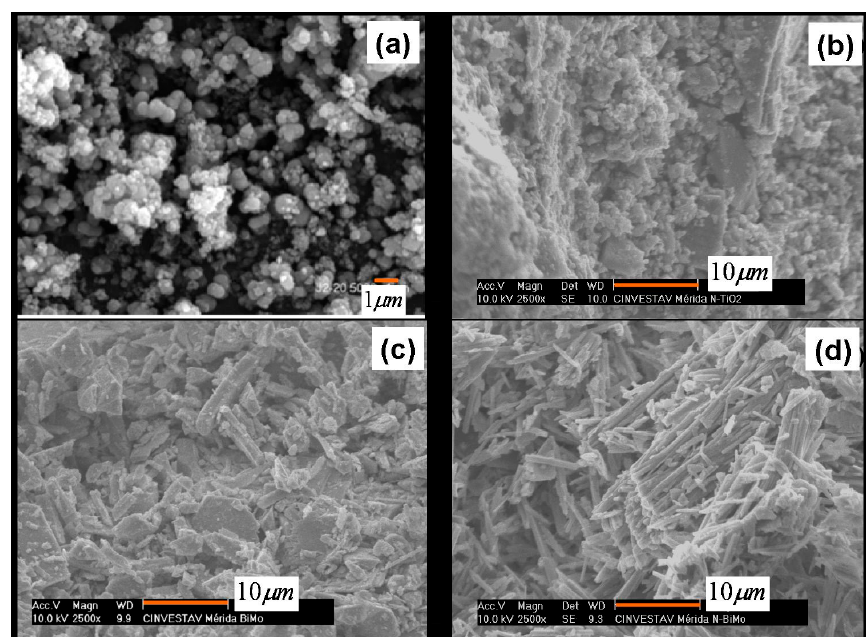
Figure 1. Scanning Electron Microscopy (SEM) photo-micrograph obtained at 5000X of ( a ) titanium dioxide (TiO 2 ), ( b ) nitrogen-doped titanium dioxide (N-TiO 2 ), ( c ) bismuth molybdate (Bi 2 MoO 6 ), and ( d ) nitrogen-doped bismuth molybdate (N-Bi 2 MoO 6 ) Bi 2 MoO 6 catalysts.